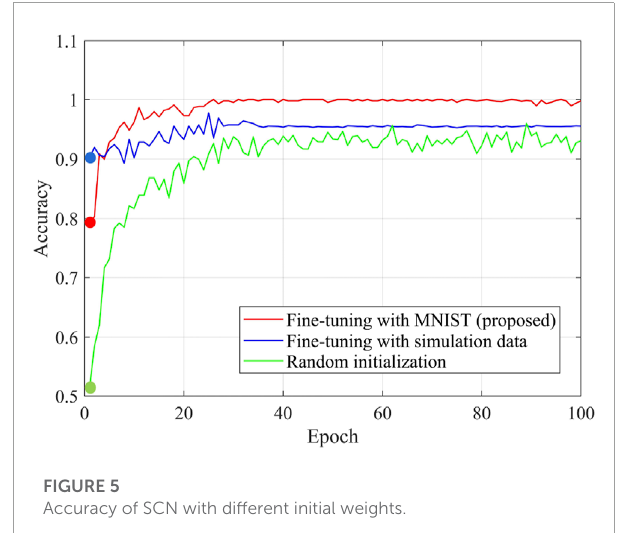
FIGURE 5 Accuracy of SCN with different initial weights.